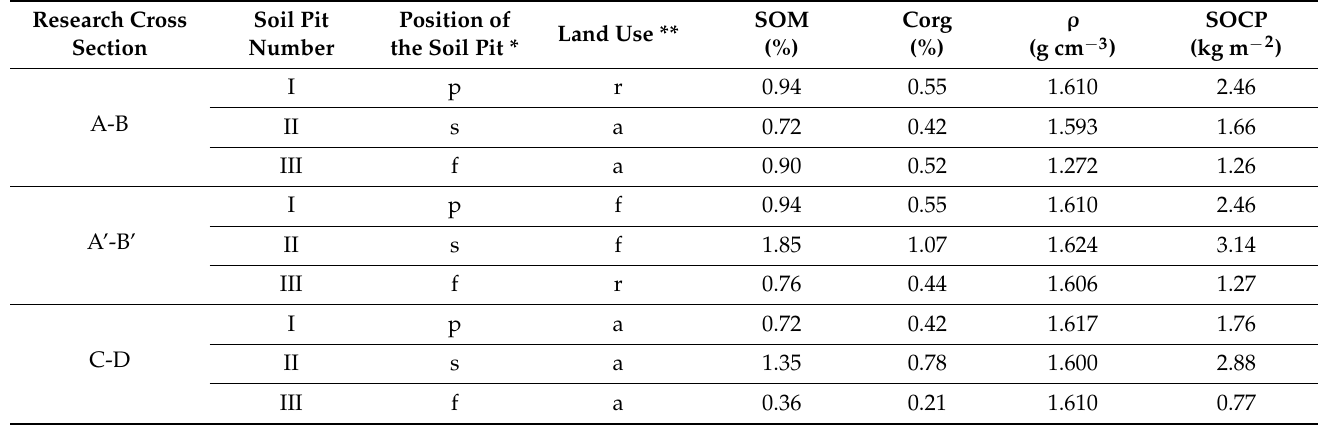
Table 1. Soil organic matter content, soil organic carbon content, soil bulk density, and pools (stocks) of soil organic carbon accumulated in the surface layers (topsoil) along the analyzed cross